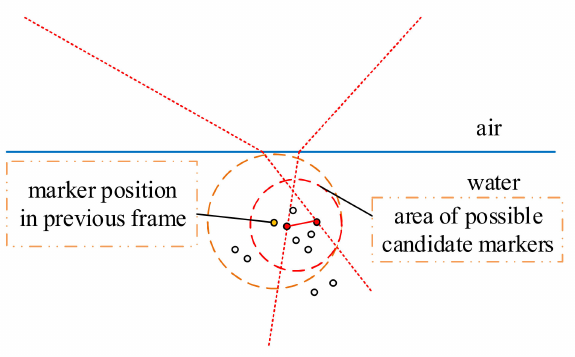
Figure 5. Marker forecast processed by Kalman